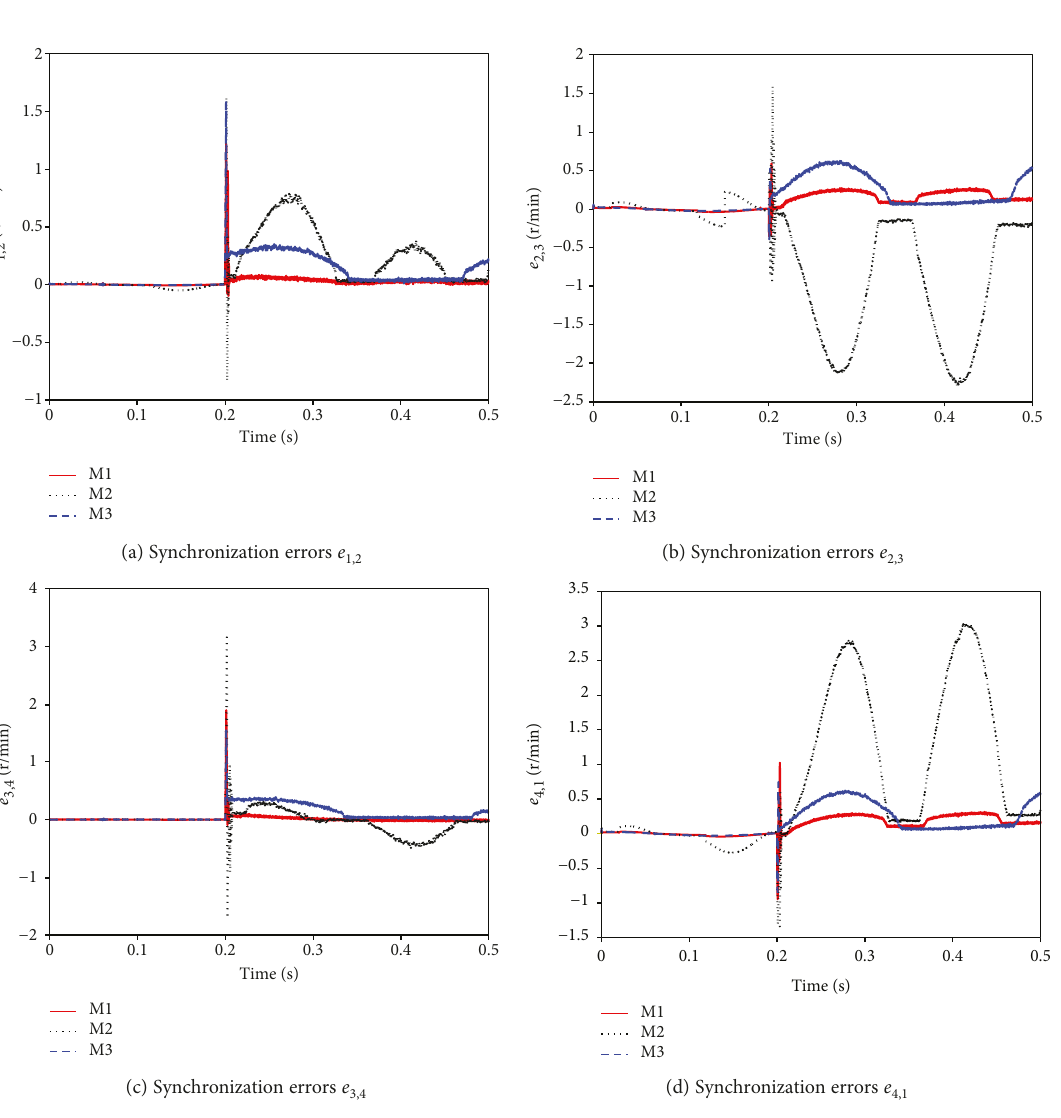
Figure 11: Synchronization error